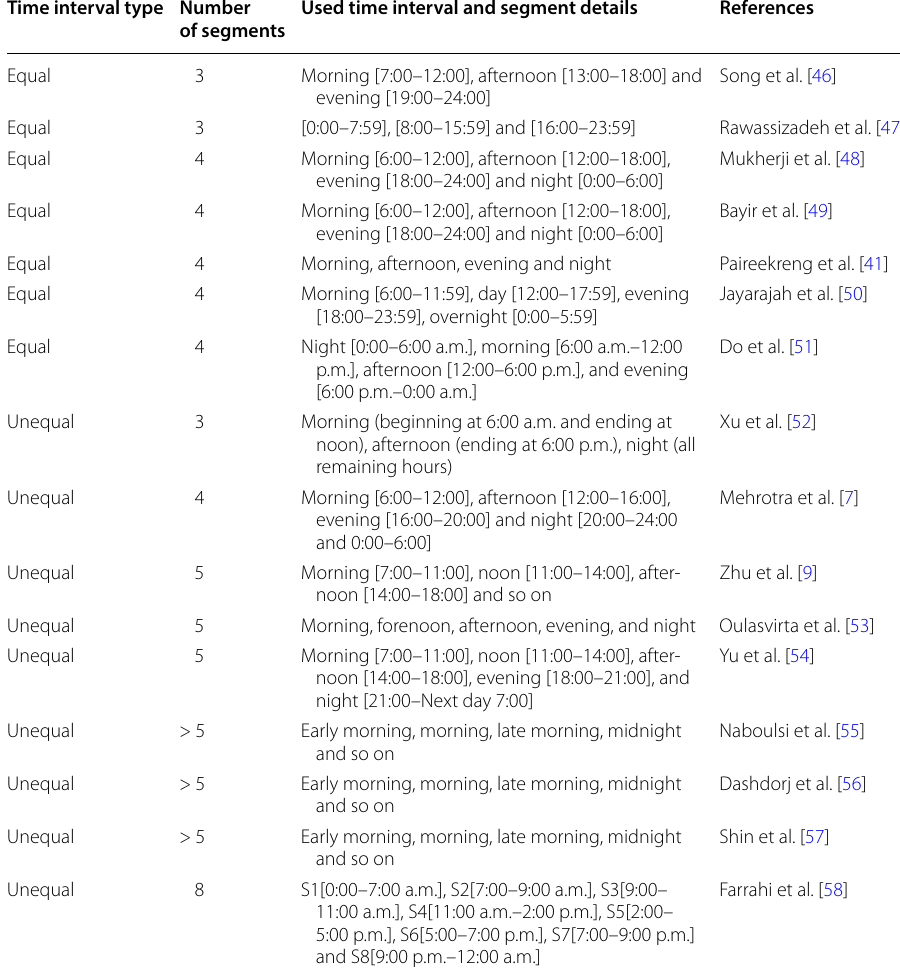
Table 1 Various types of static time segments used in different applications Time interval type Number Used time interval and segment of segments